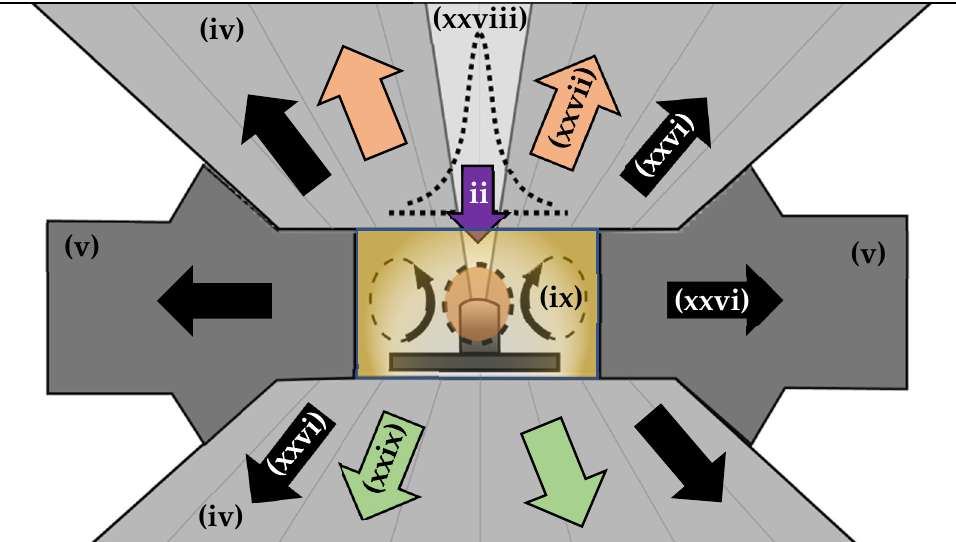
Figure 8. Schematic of heat and mass transport in an LRS-DAC. The laser is focused ( ii ) to selectively heat only a portion of the chamber, specifically a small reaction zone. Where the precursor medium is in a liquid state, (rapid) convection cells ( ix ) can form inside the gasket chamber. This transfers heat from the reaction zone to the surrounding diamond anvils ( iv ) and gasket ( v ), and moves the precursor to the reaction zone and byproducts from this zone.